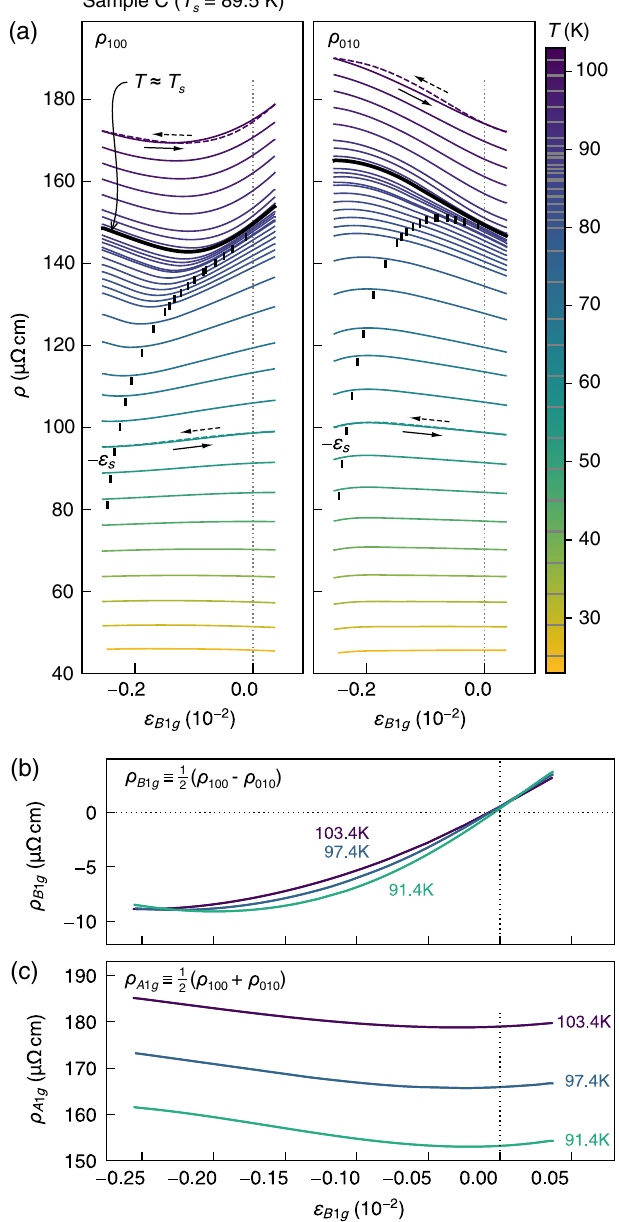
FIG. 6. Data from sample C, the Montgomery configuration sample. (a) ρ 100 (left) and ρ 010 (right), from strain ramps at various fixed temperatures. The hysteresis is shown for two temperatures. The vertical ticks mark − ε Ref. [40] and scaled in temperature to match the T ≡ ð ρ − ρ Þ = 2 , derived from the data in (a), at here. (b) ρ 100 010 B 1 g temperatures above T . Note that by symmetry ρ s ¼ 0 , but measurement error gives a small deviation from at ε B 1 g ≡ ð ρ þ ρ Þ = 2 this. (c) ρ 100 010 A 1 g